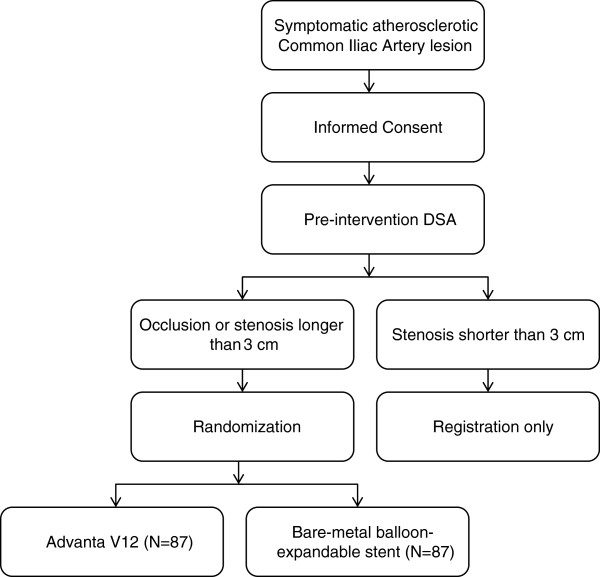
Flowchart describing the inclusion and randomization of patients.